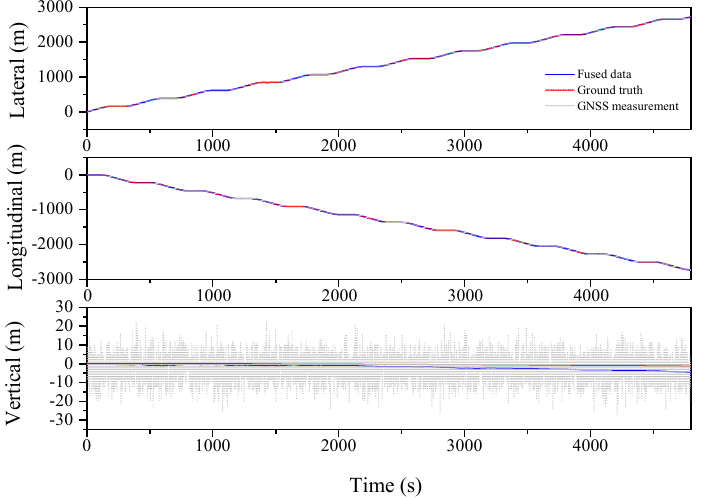
Figure 8. Lateral, Longitudinal and Vertical positions of ESKF (Serpentine 1).